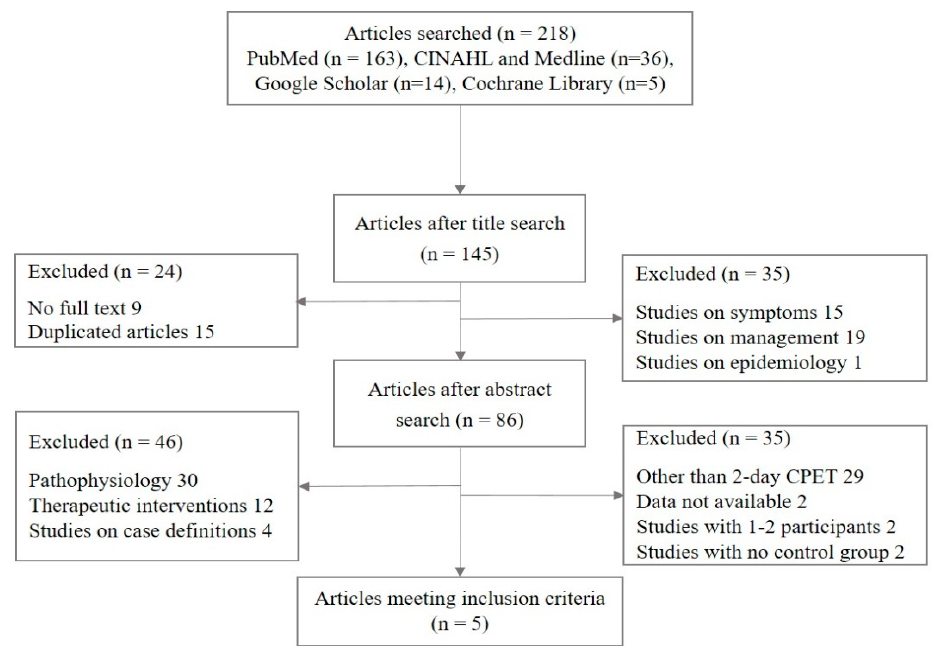
Figure 1. Flow chart of the study selection